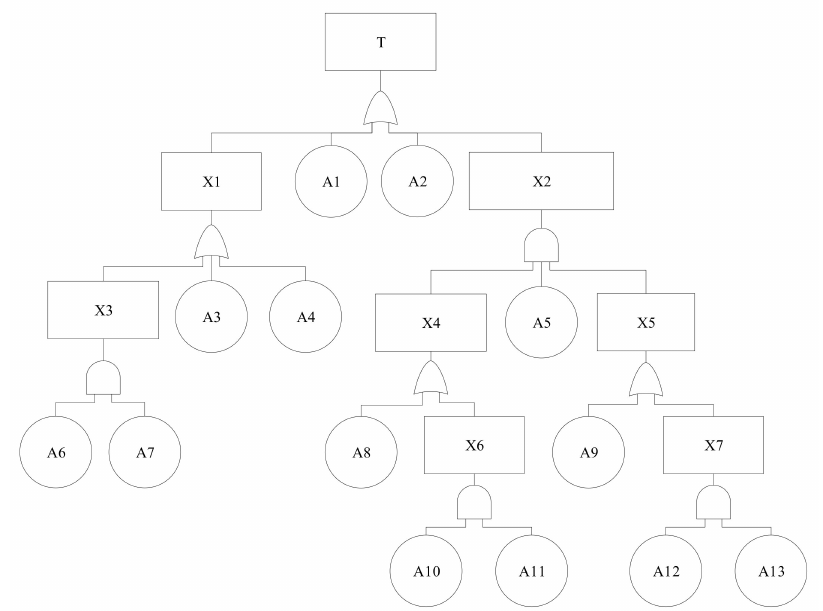
Figure 10. Simplified fault tree of brake